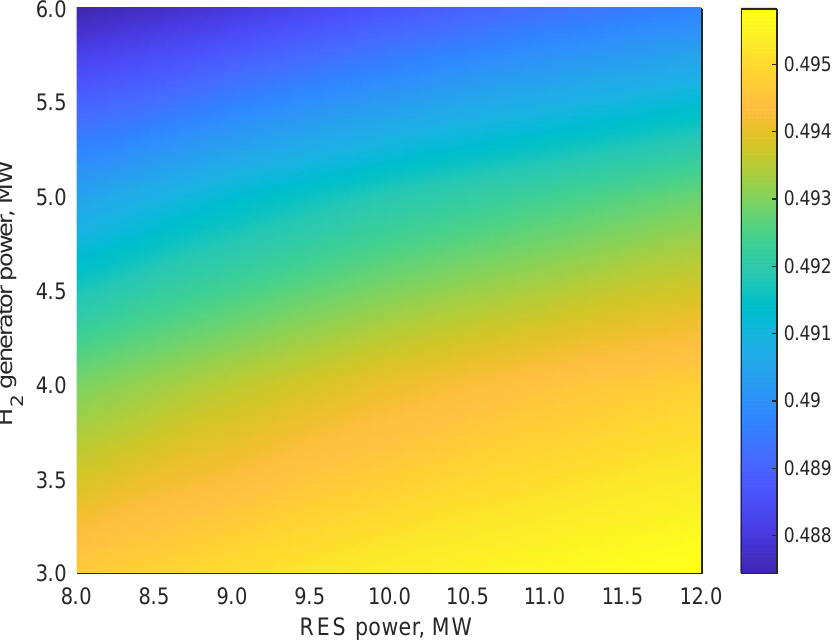
Figure 9. Plot showing the influence of the selected rated power of the renewable energy source and the hydrogen generator on the average annual efficiency of SNG production, η avg